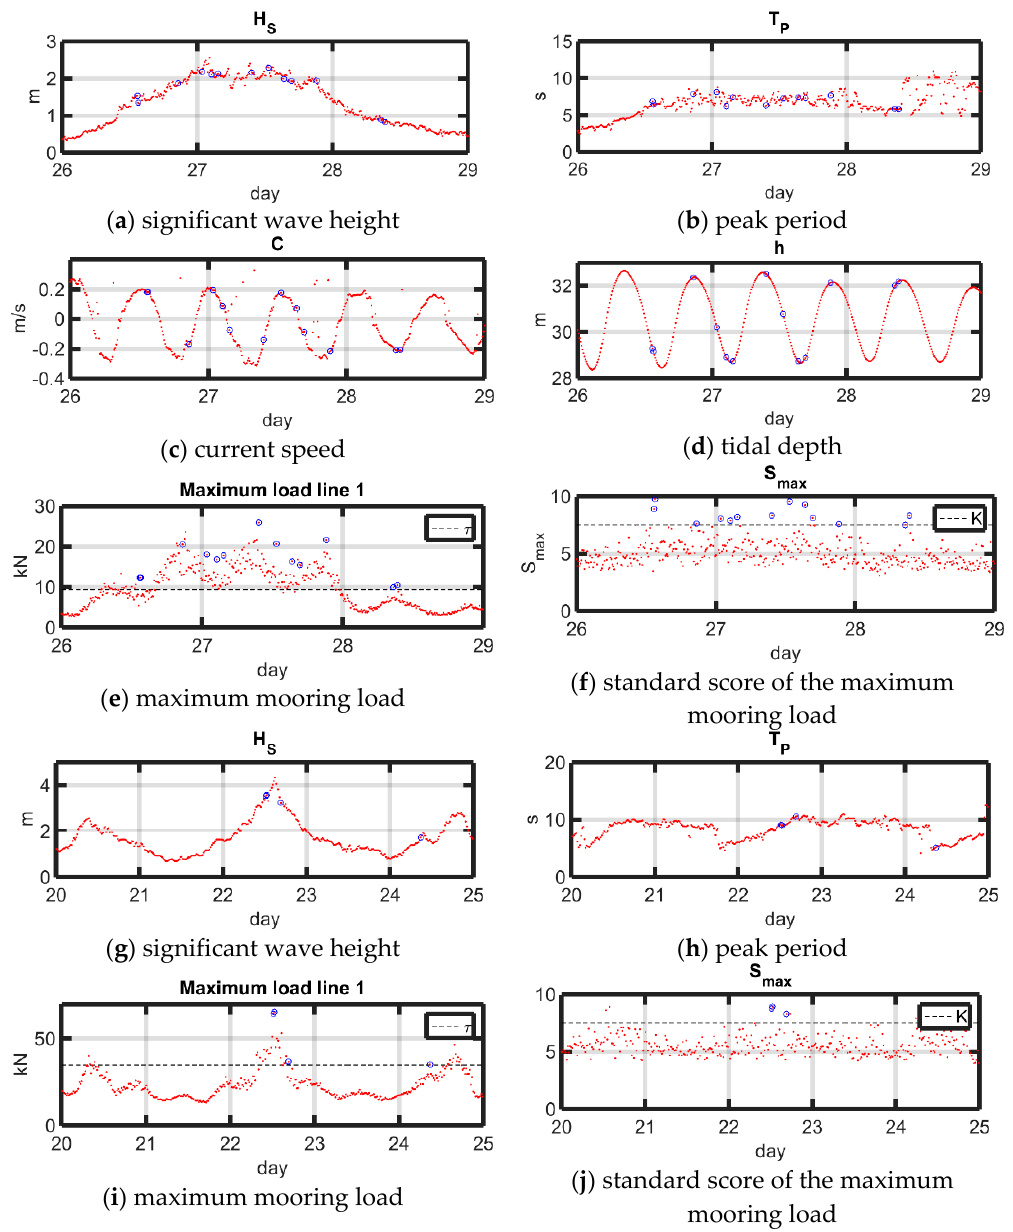
Figure 5. Example of sea trial measurements for several days (red dots) and the detection of peak mooring loads and their corresponding environmental conditions (blue circles): at SWMTF: ( a ) H S ; ( b ) T P ; ( c ) C ; ( d ) h ; ( e ) maximum mooring load on line 1; and ( f ) standard score of the maximum mooring load S max on line 1; at the Bolt ‐ 2 Lifesaver installation: ( g ) H S ; (h) T P ; ( i ) maximum mooring load on line 1; and ( j ) standard score of the maximum mooring load S max on line 1.